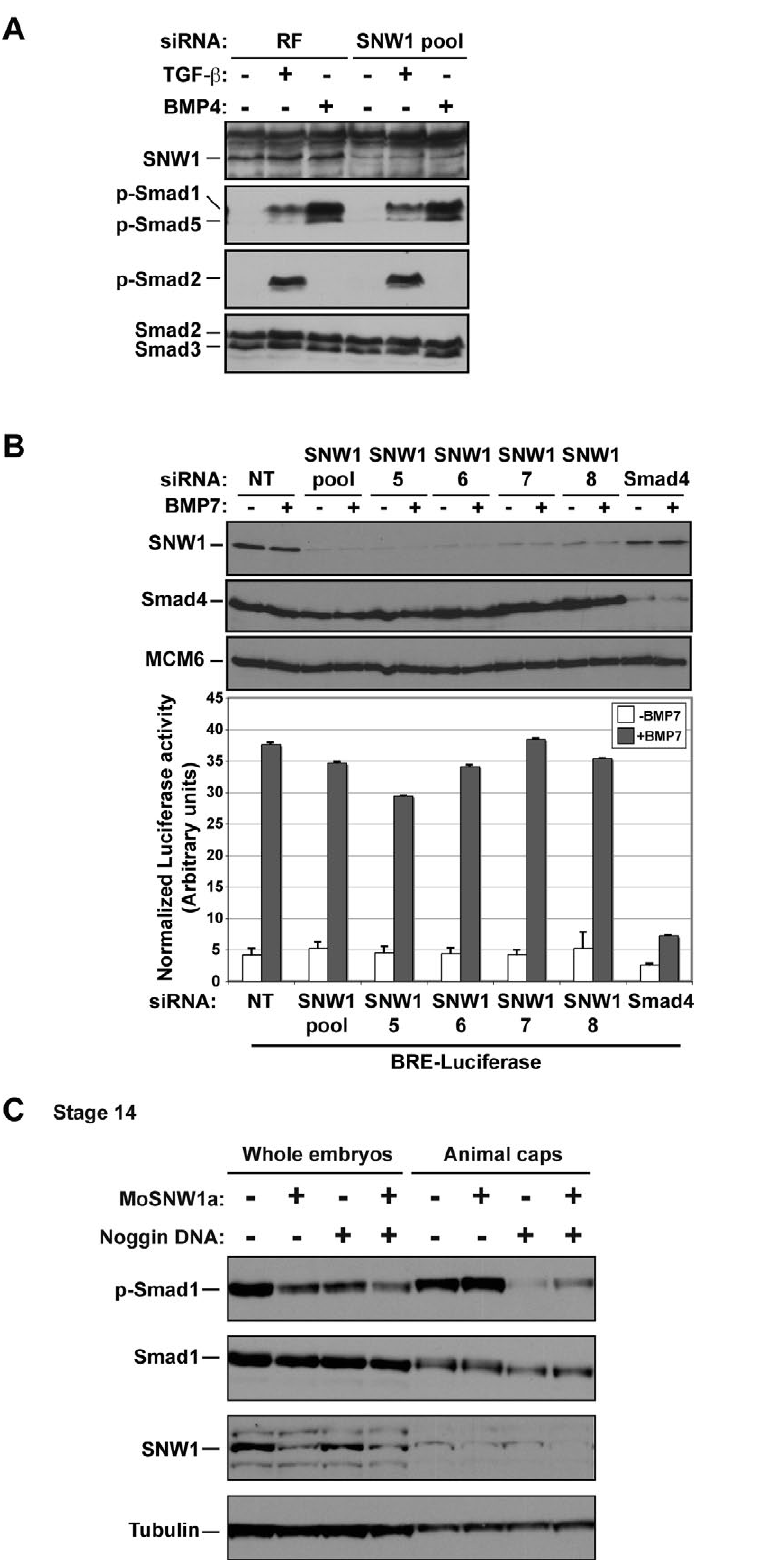
Figure 7. SNW1 does not function downstream of the receptors in the BMP pathway in tissue culture cells or in Xenopus animal cap explants. (A) Knockdown of SNW1 had no effect on the levels of p-Smad1/5 or p-Smad2 in response to ligand stimulation. SNW1 was depleted in MDA-MB-231 cells using an siRNA pool containing four individual duplexes that specifically target the human SNW1 mRNA. 72 h after siRNA transfection, cells were either left uninduced or induced for 1 h with 20 ng/ml BMP4 (R&D Systems) or 2 ng/ml TGF- b (PeproTech). Whole cell extracts